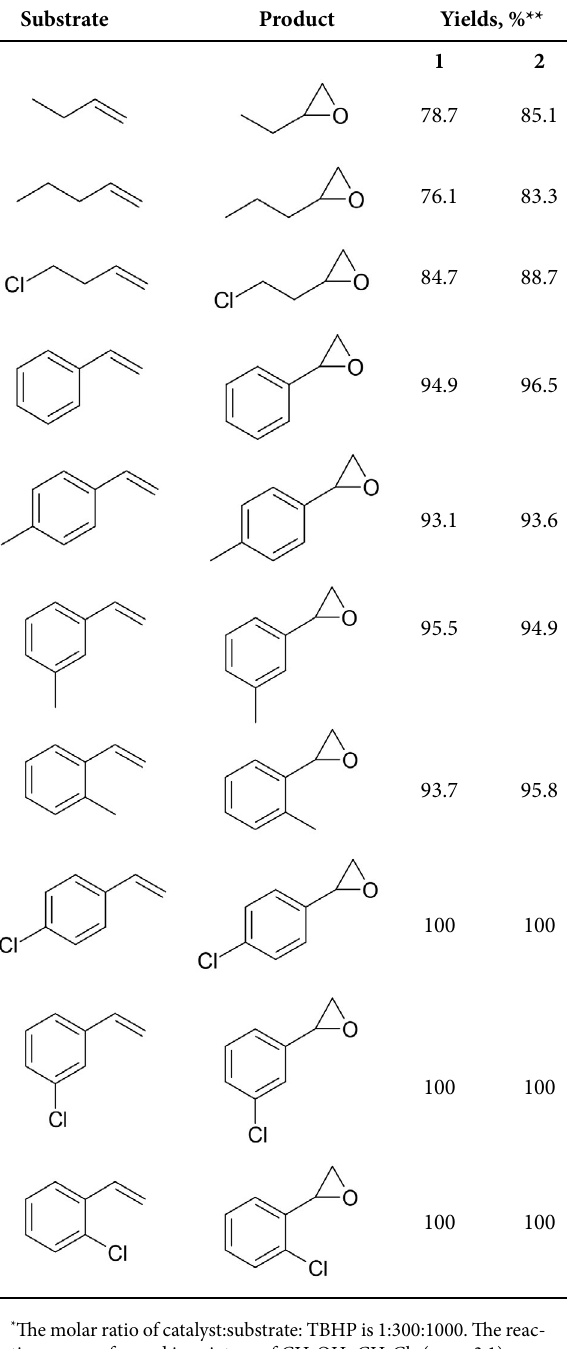
Table 4. Details of the catalytic oxidation of olefins catalyzed by the complexes * Substrate